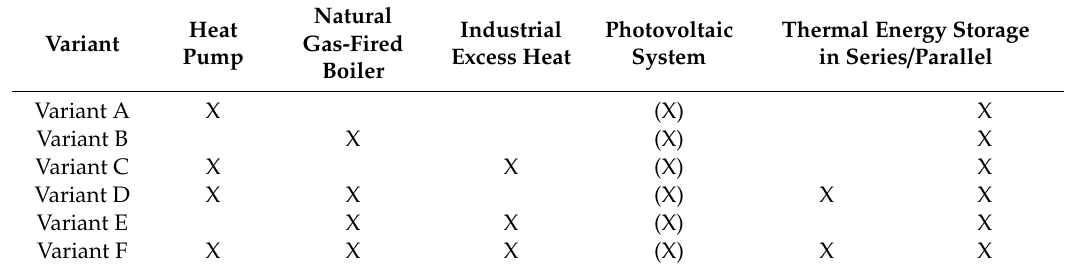
Table 1. List of feasible combinations of heat provisioning elements based on the